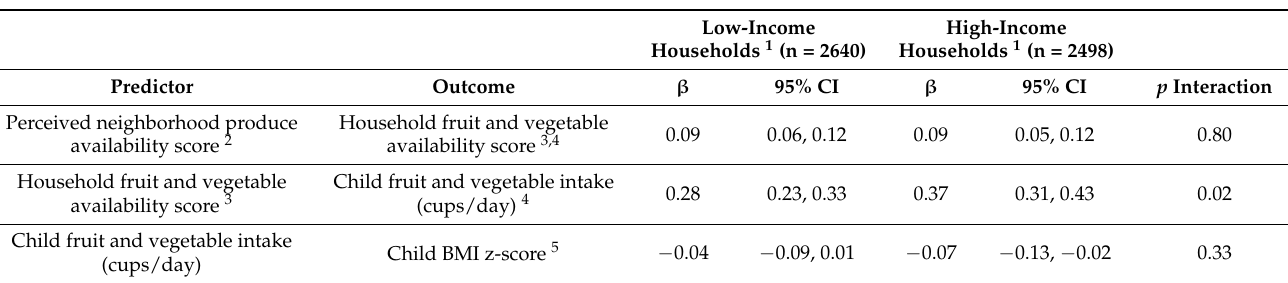
Table 4. Select relationships between perceived neighborhood produce availability, household fruit and vegetable availabil- ity, child fruit and vegetable intake, and child body mass index z-score (BMI z-score) in the Healthy Communities Study, by annual household income (N =